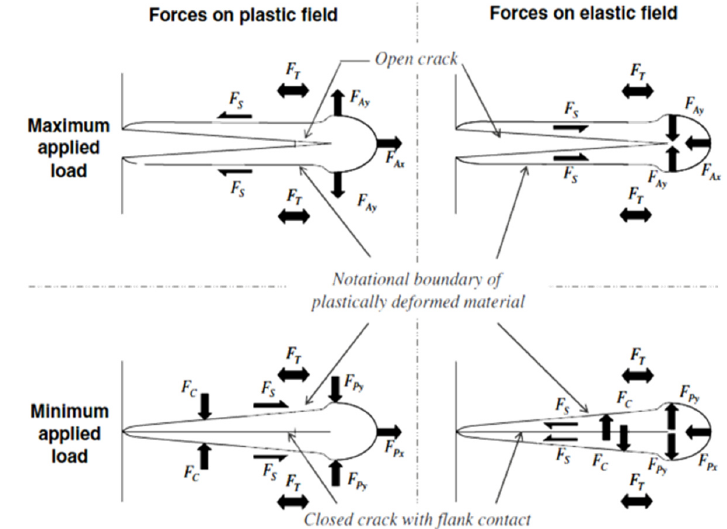
Figure 1: Schematic idealisation of the forces acting at the elastic-plastic boundary